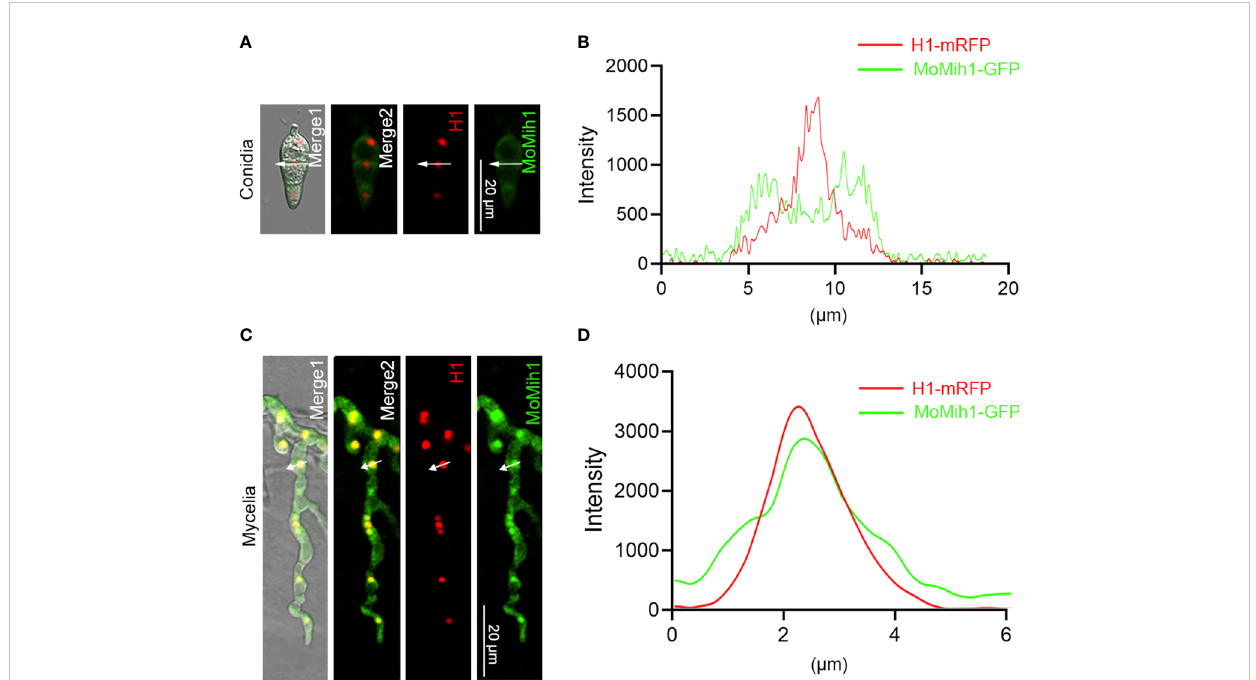
FIGURE 2 The subcellular localization of MoMih1 in M. oryzae . (A) The conidia of the transformants co-expressing the MoMih1-eGFP and H1-mRFP fusion protein were examined under a CLSM. Bar = 20 m m. (B) Line scan graph analysis of the fl uorescence. Line scan graph indicates that MoMih1 don ’ t colocalized with the histone protein at spore stage. (C) The hyphae of the transformants co-expressing the MoMih1-eGFP and H1-mRFP fusion protein were examined under a CLSM. Bar = 20 m m. (D) Line scan graph analysis of the red and green fl uorescence. Line scan graph analysis of fl uorescence indicates the co-localization of MoMih1 with histone at